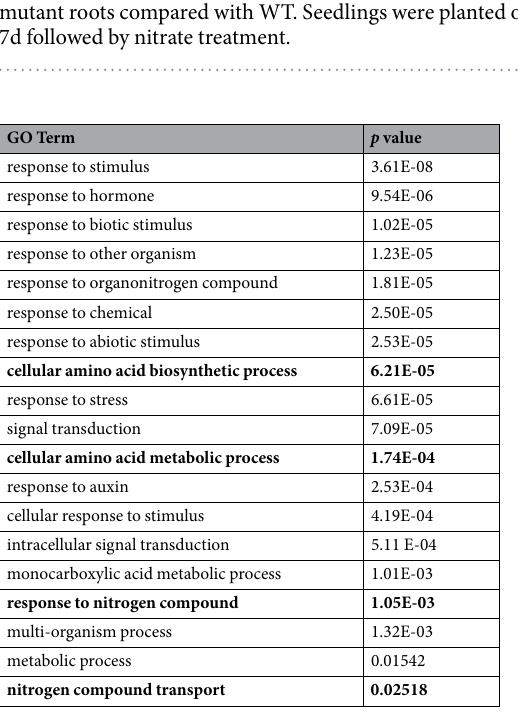
Table 1. GO analysis for the nitrate responsive genes that are modulated by both NRT1.1 and NLP7